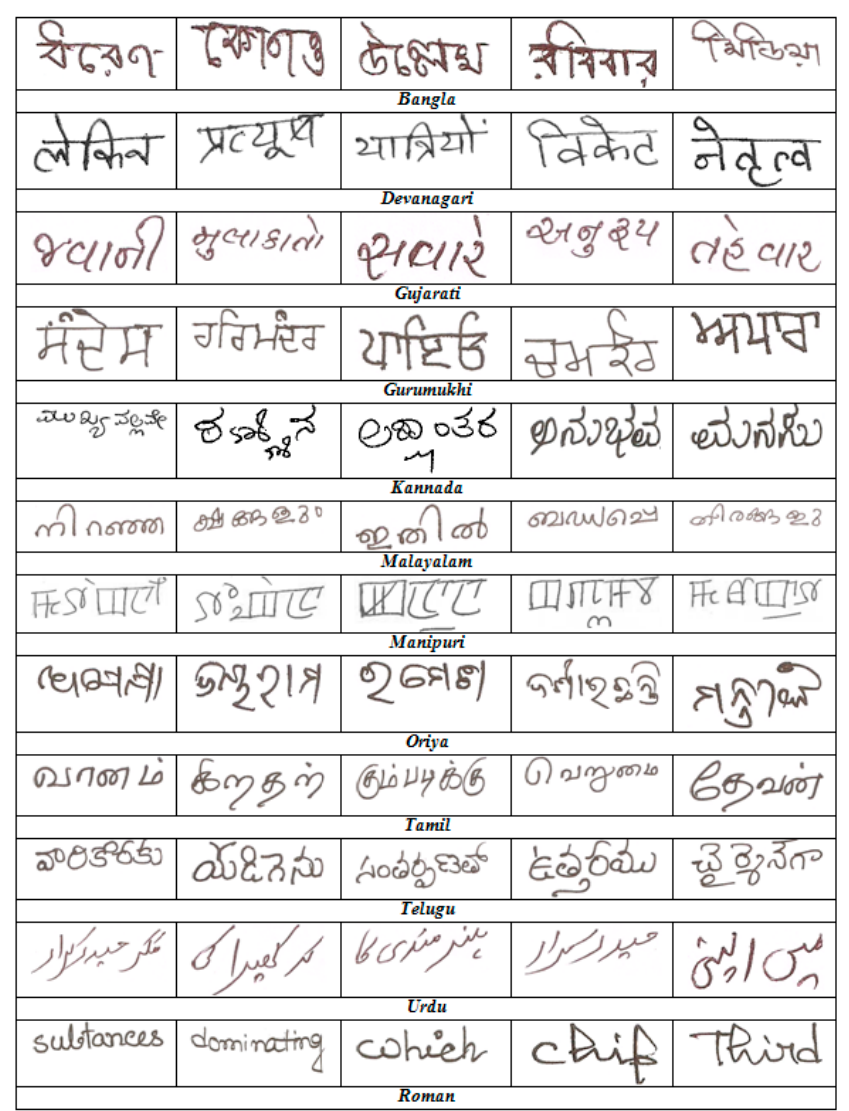
Figure 7. Sample word images written in 12 different Indian scripts.